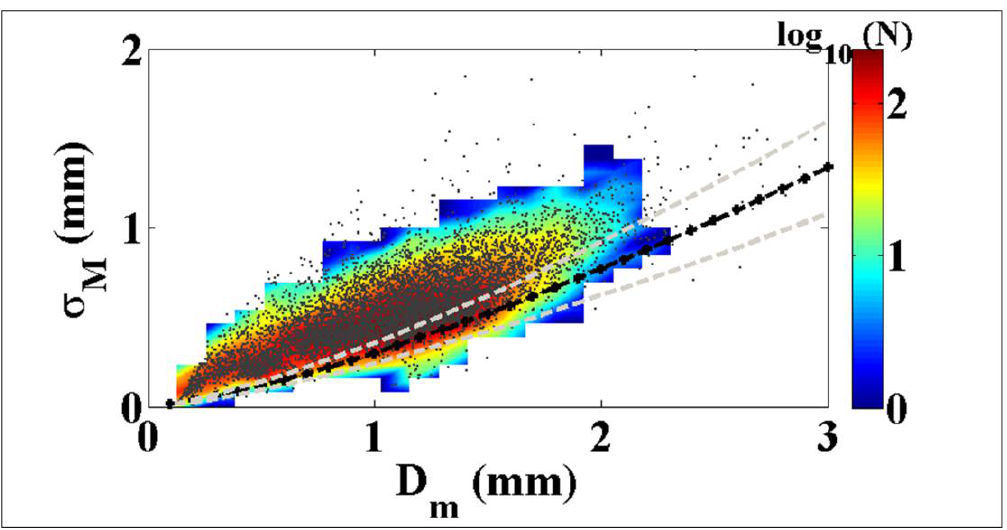
Figure 6. D m versus σ M from one-minute DSDs (color intensity) compared with the corresponding GG-fitted variations (black dots). The black line is Equation (22) in Williams et al. [42] and the grey lines are their Equations (23) and (24).